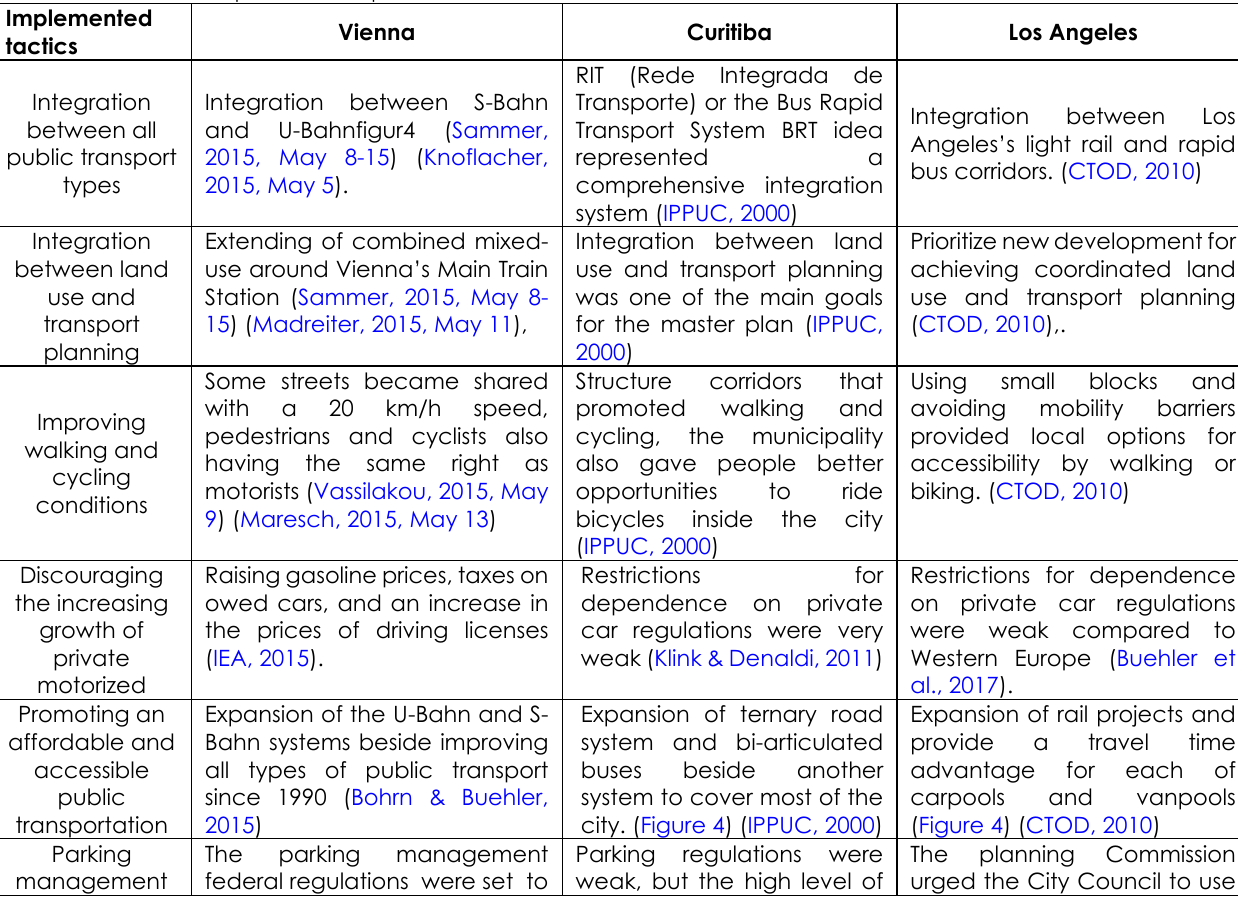
Figure 4. The distinctive TOD ideas in each of the case studies – Source (IPPUC, 2000) (GJEL, 2015). Table 2. Sustainable transport and TOD